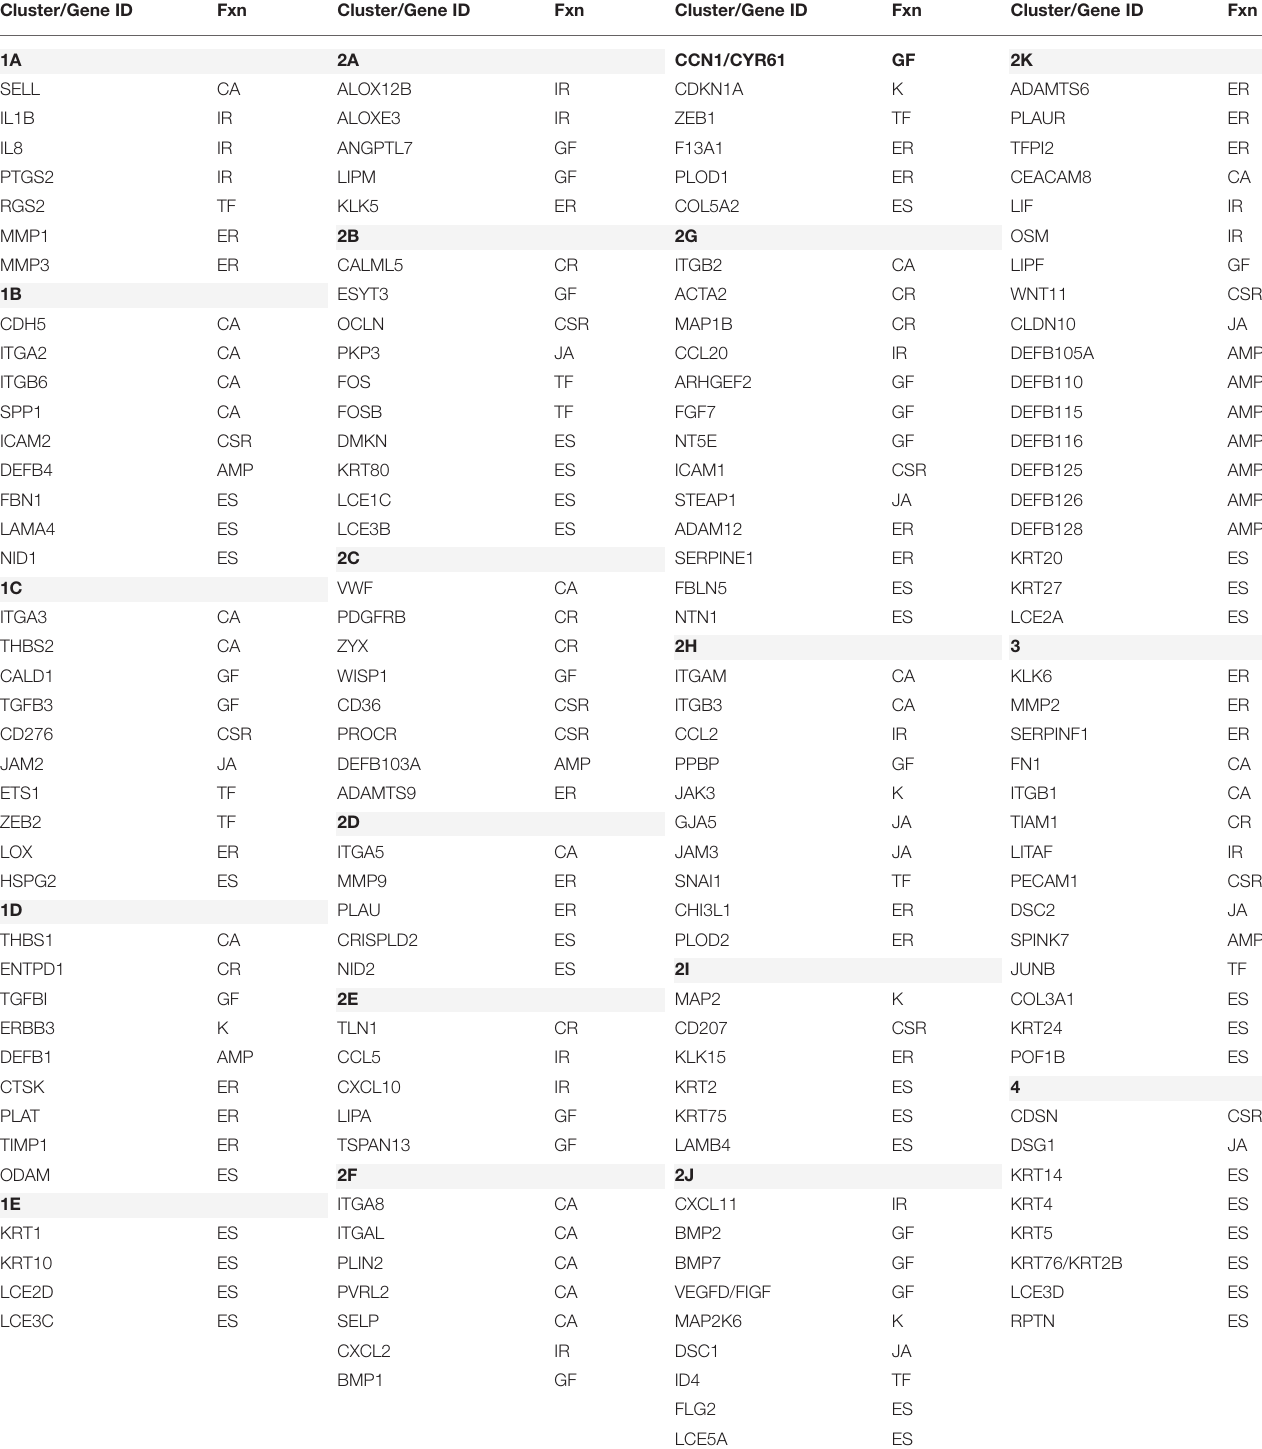
TABLE 3 | Characteristics of gene clusters. Functional categories (Fnx) are defined as follows: AMP, antimicrobial peptide; CA, cell adhesion; CSR, cell surface receptor; CR, cytoskeleton regulation; ER, ECM remodeling; ES, ECM structural; GF, growth factor; IR, inflammatory response; JA, junction associated; K, Kinase; TF, transcription